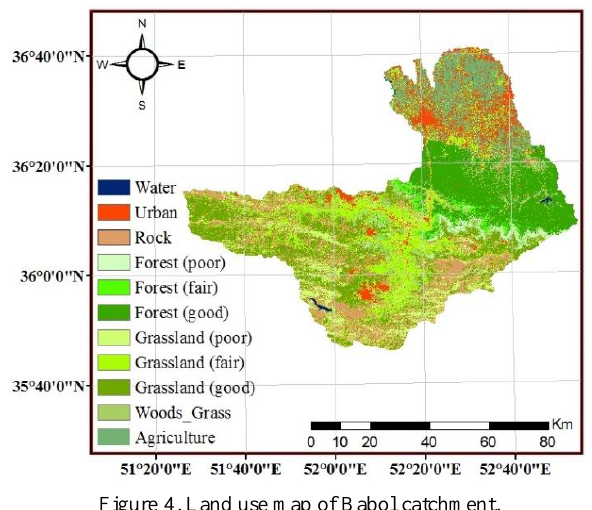
Figure 4. Land use map of Babol catchment.